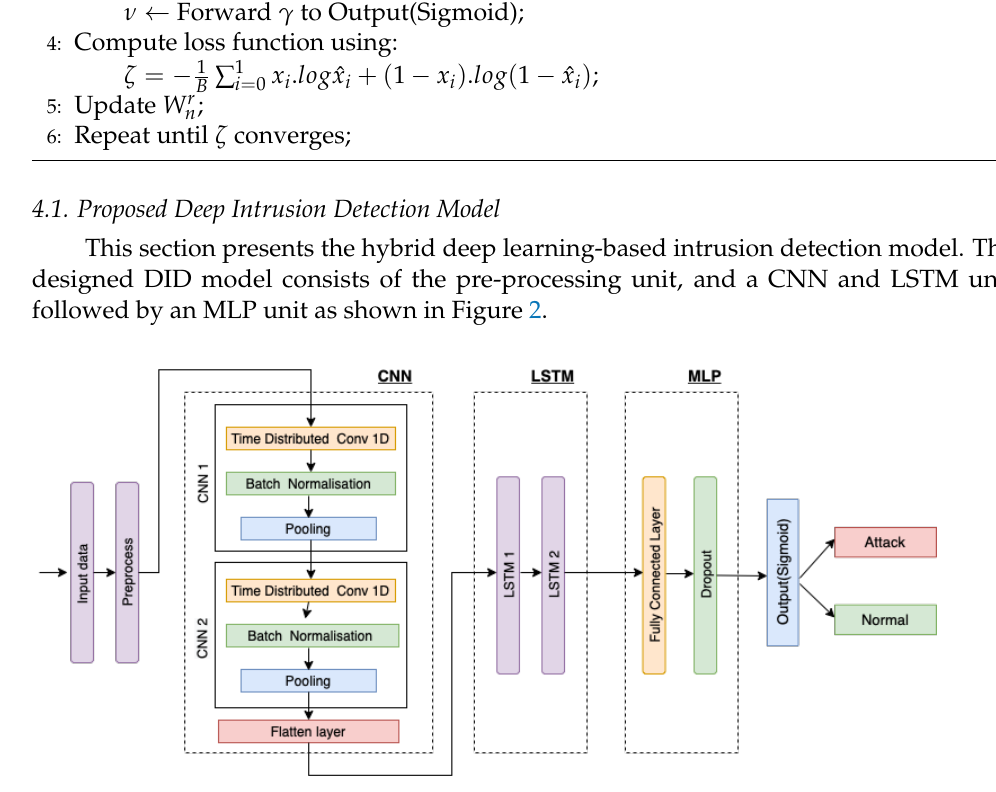
Figure 2. Architecture of designed DL